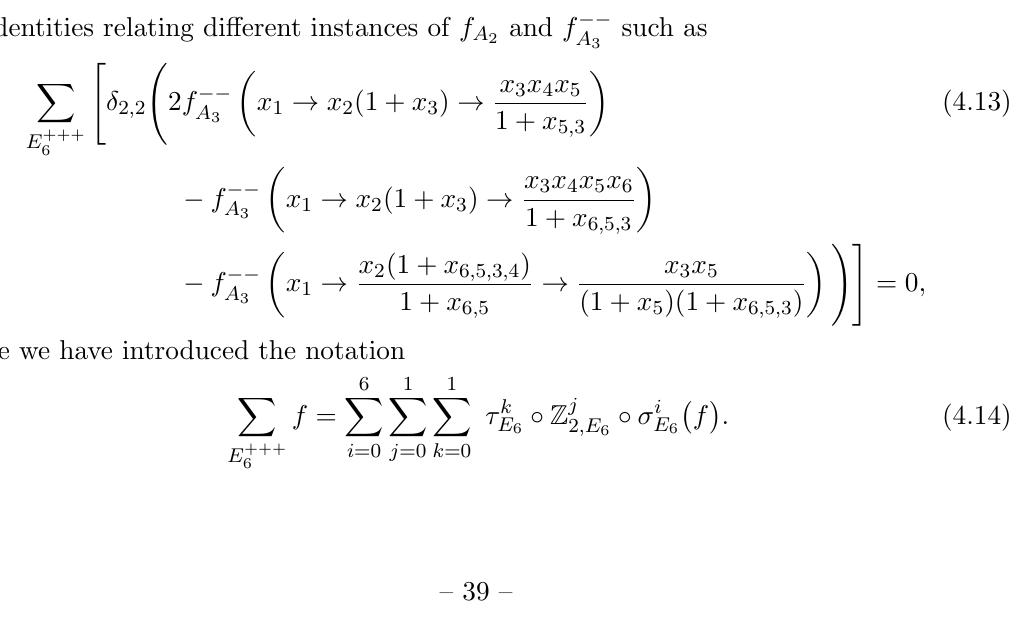
Table 4. The number of f (cid:0)(cid:0) its subalgebras, with each possible automorphism